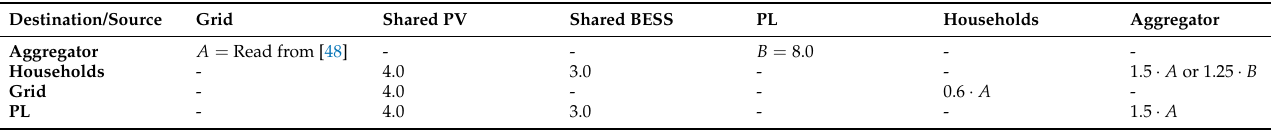
Table 9. Prices for calculating aggregators’ and households’ profits (expressed in $/MWh). Columns represent the source of energy and rows represent the destination. The price of the energy purchased by the aggregator from the utility grid is indicated as “A”, while “B” indicates the price of the energy from the EVs in the parking lot. Destination/Source Grid Shared PV Shared BESS PL